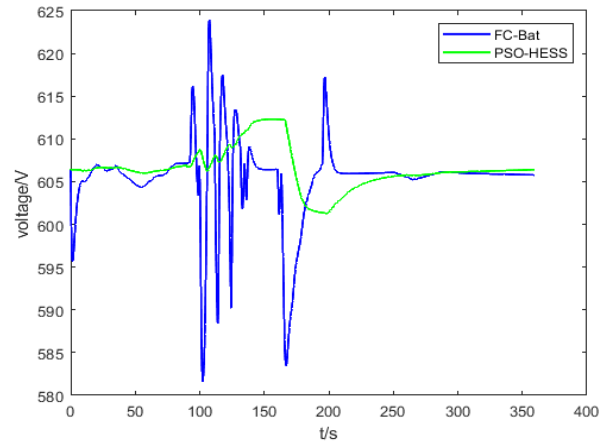
Figure 7. Comparison of bus voltage simulation.